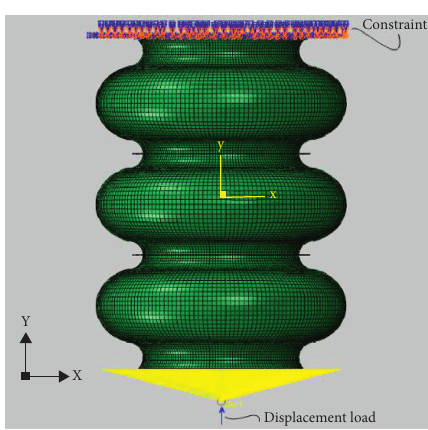
Figure 8: Finite-element model and restraint load of the airbag.